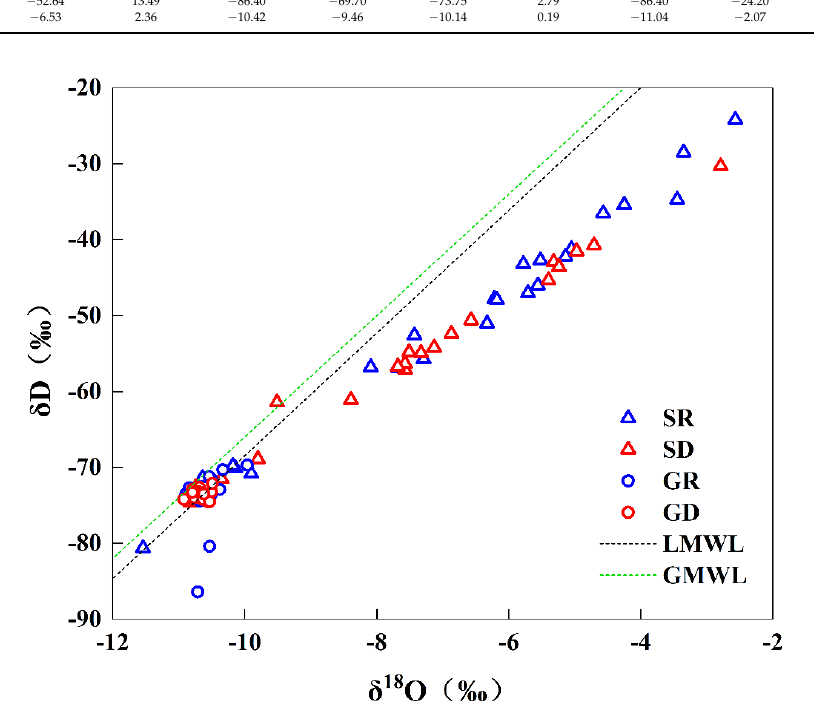
Figure 5. Distribution of δ 2 H and δ 18 O in NKWS.